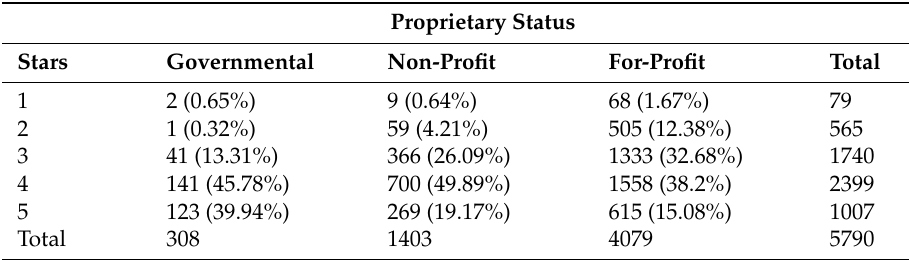
Table 5. Star rating distribution by type of HHA ownership.